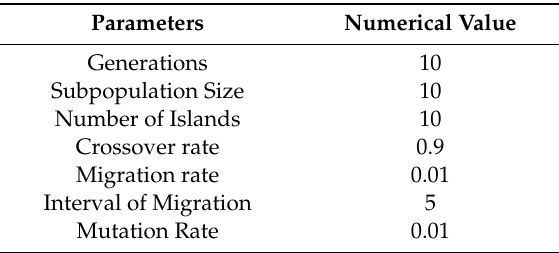
Table 10. Optimization parameters adopted in MIGA.